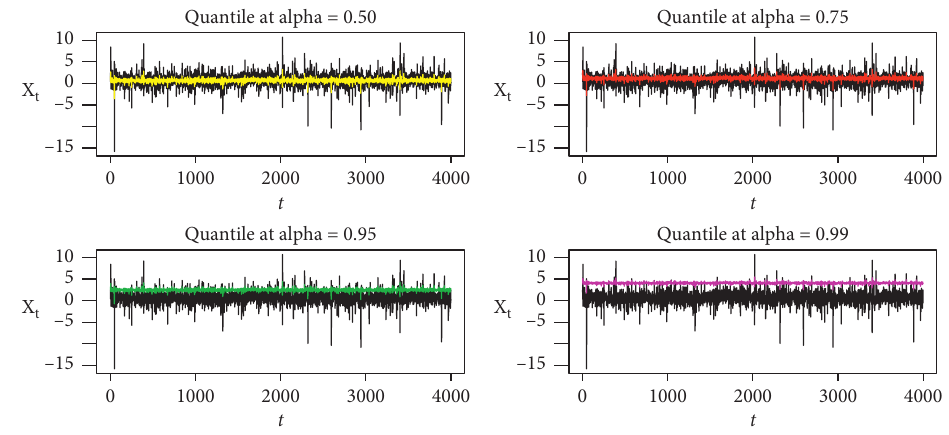
Figure 4: Quantile estimates at various α -levels for θ � 50%.